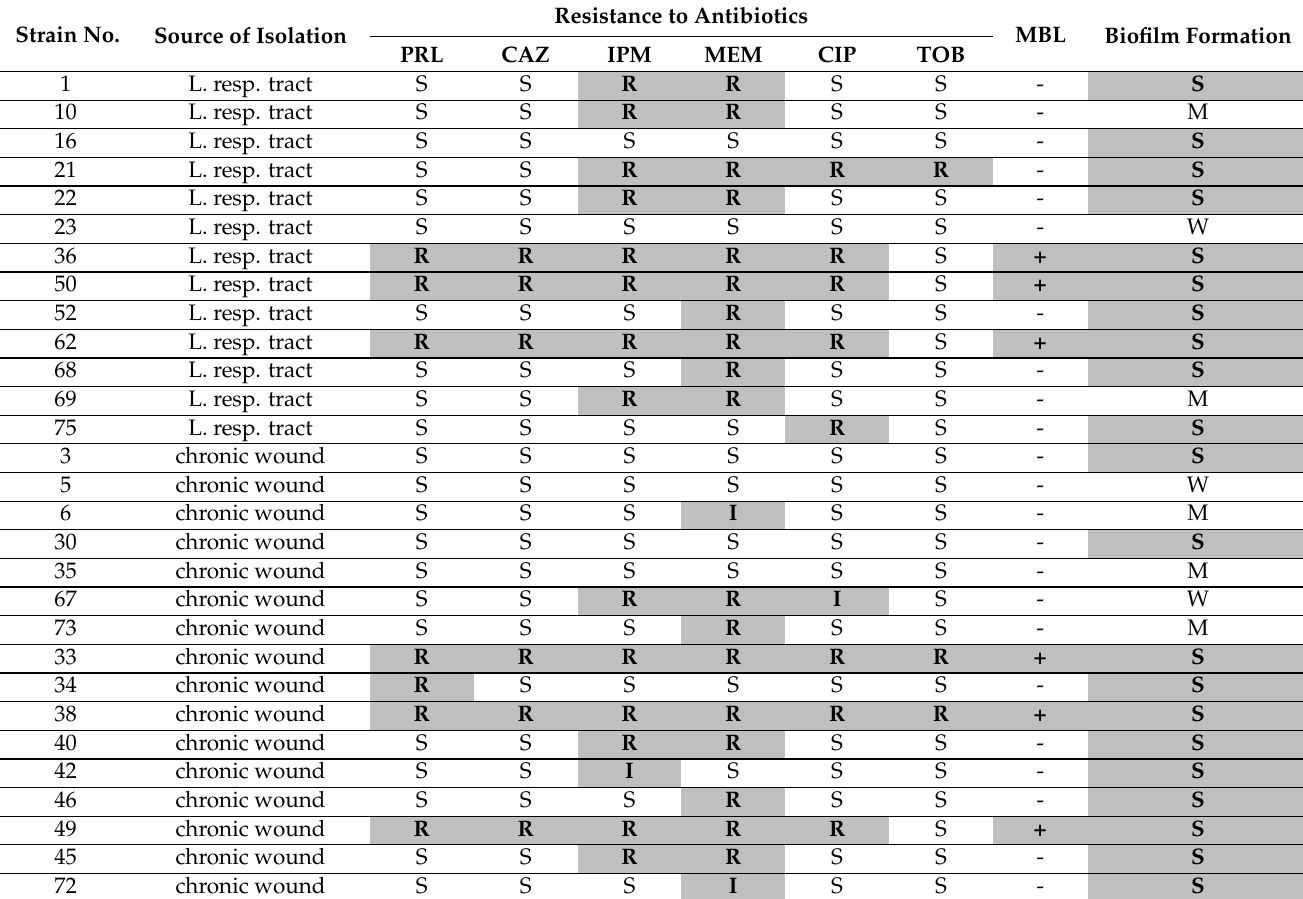
Table 1. Characteristics of P. aeruginosa strains using selected phenotypic and genotypic